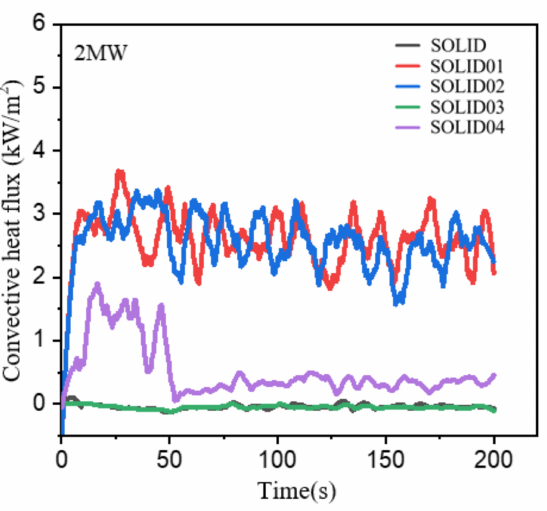
Figure 16. Variation of convective heat flux of glass under window sprinkler conditions.